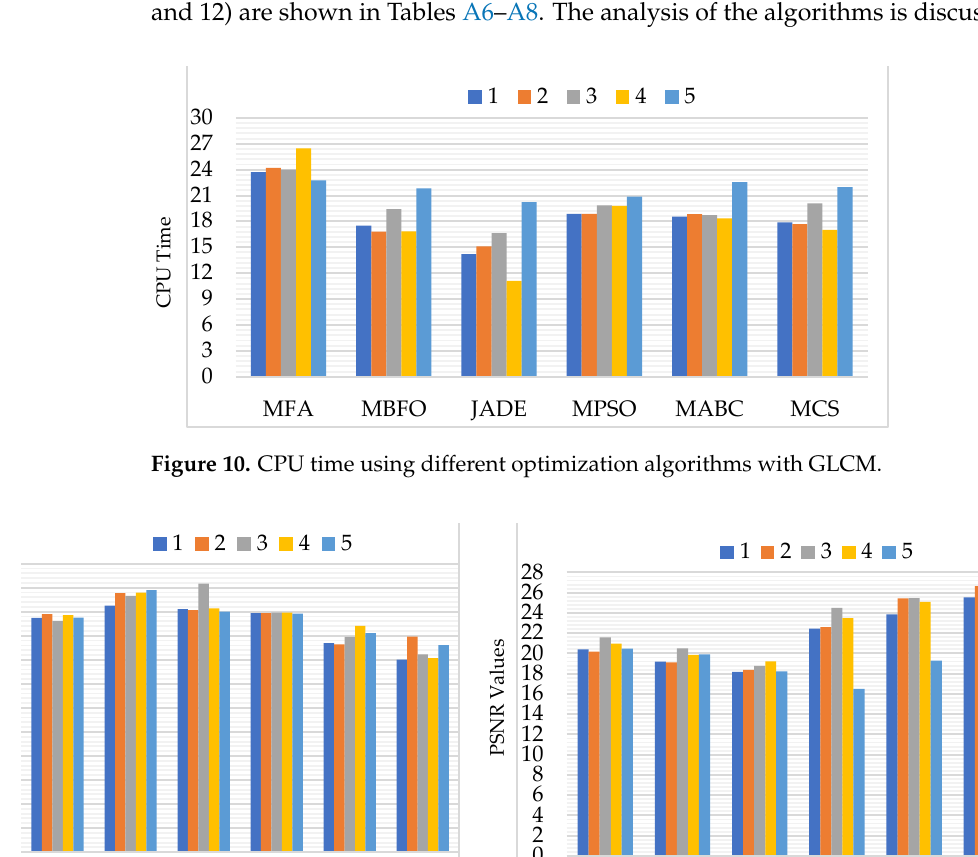
Figure 11. PSNR and MSE using different optimization algorithms with GLCM.